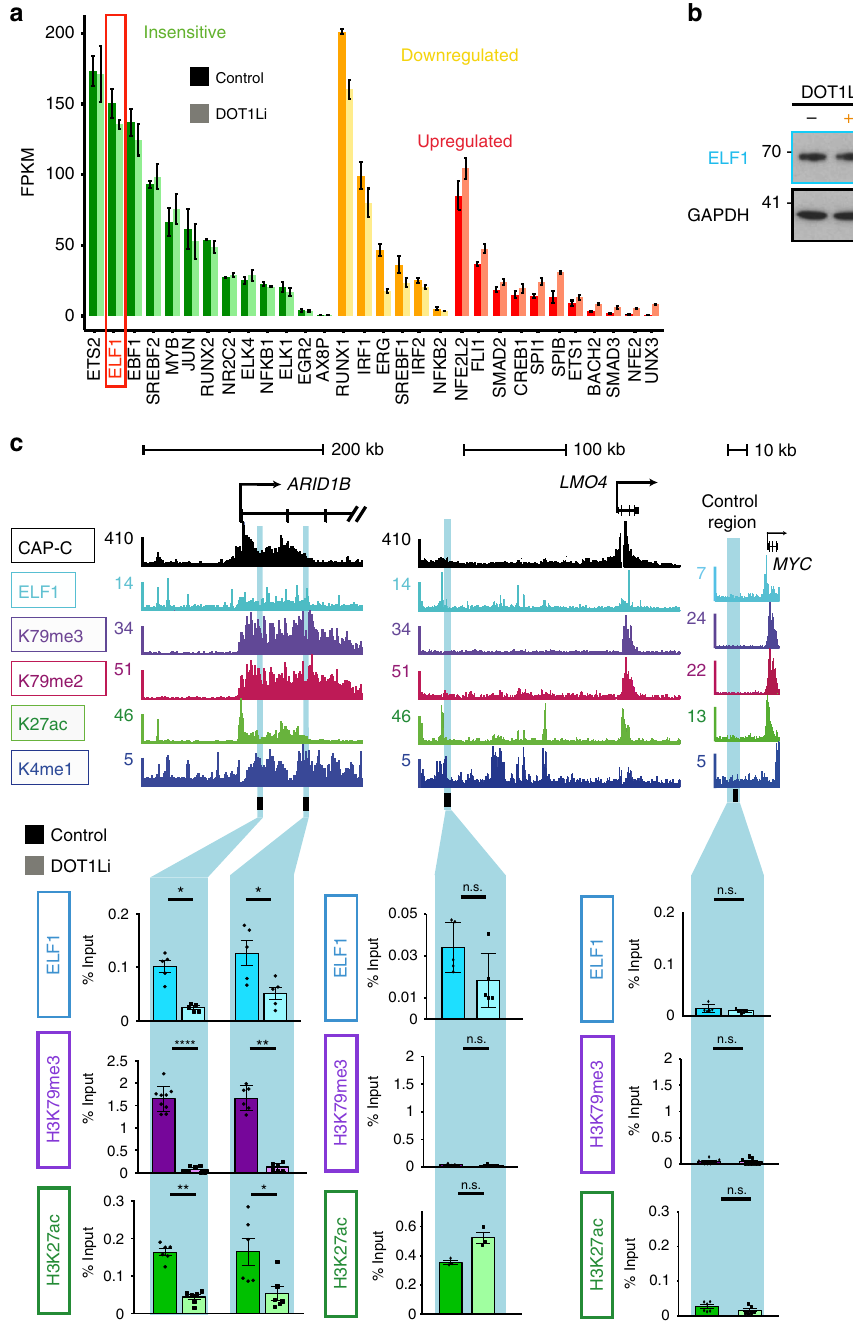
Fig. 4 Loss of H3 lysine 79 methylation 2/3 (H3K79me2/3) leads to a reduction in ELF1 binding at H3K79me2/3 Enhancer Elements (KEEs). a Expression level of transcription factors whose motifs are enriched at KEEs compared to the rest of the genome, sorted into categories of transcriptionally insensitive (green), downregulated (orange), and upregulated (red) following DOT1Li. ELF1 is highlighted in a red box. b Western blot analysis of ELF1 and GAPDH following salt-soluble protein extraction of SEM cells in control ( − ) and DOT1Li ( + ) conditions. Representative of three biological replicates. c Chromatin immunoprecipitation-quantitative PCR (ChIP-qPCR) at ARID1B KEEs, LMO4 non-KEE and negative control locus for ELF1, H3K79me3, and H3 lysine 27 acetylation (H3K27ac in control (darker shade) and DOT1Li (lighter shade) conditions. n = 6, error bars represent s.e.m. * P < 0.05, ** p < 0.005, **** p < 0.0001 using a Mann – Whitney U test. n.s. not signi fi cant. Source data are provided as a source data fi le. See also Supplementary Fig. Taking these data together, we propose that the increases in H3K9me3 following DOT1Li do not explain the speci fi c changes in TF binding at KEEs. However, there is clear link between H3K79me2/3-dependent H3K27ac, chromatin accessibility, and TF binding at KEEs, consistent with the increased transcriptional sensitivity of KEE genes to DOT1Li.